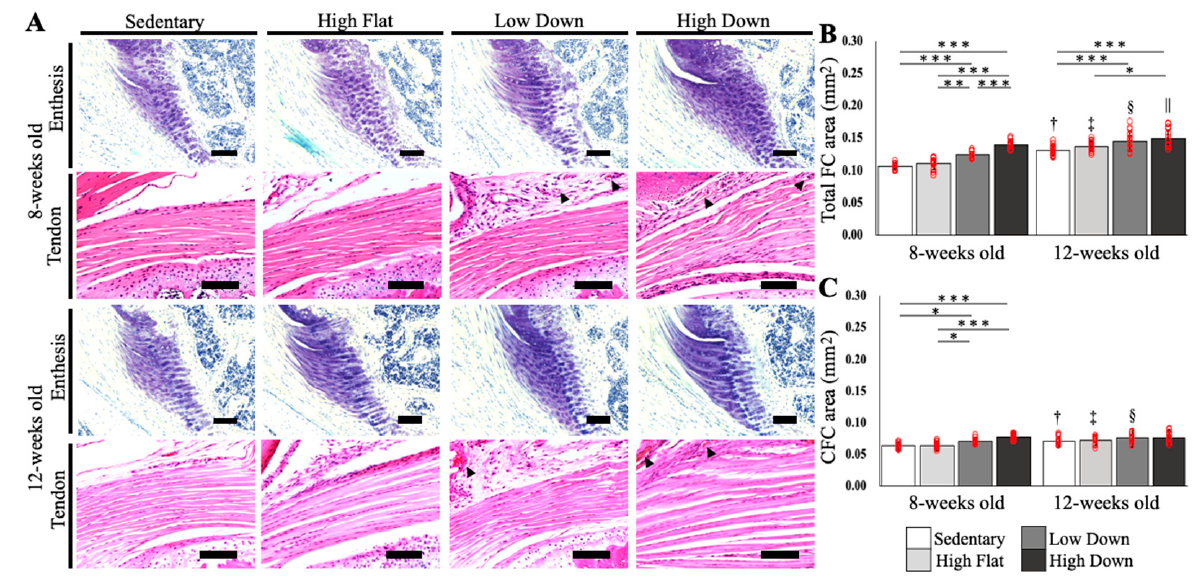
Figure 3. Histological changes in the fibrocartilage of the enthesis and tendon. ( A ) Histological images of TB staining for enthesis FC and HE staining for the tendon are shown. Black arrowhead: angiogenesis. Scale bar; 100 µm. ( B ) Comparison results of the FC area are shown. ( C ) Comparison results of the CFC area. Statistical significance: * p < 0.05, ** p < 0.01, *** p < 0.001. † p < 0.05 (8-week-old mice in the Sedentary group vs. 12-week-old mice in the Sedentary group), ‡ p < 0.05 (8-week-old mice in the High Flat group vs. 12-week-old mice in the High Flat group), § p < 0.05 (8-week-old mice in the Low Down group vs. 12-week-old mice in the Low Down group), || p < 0.05 (8-week-old High Down group vs. 12-week-old High Down group). CFC, calcified fibrocartilage; TB, toluidine blue; HE, hematoxylin and eosin.